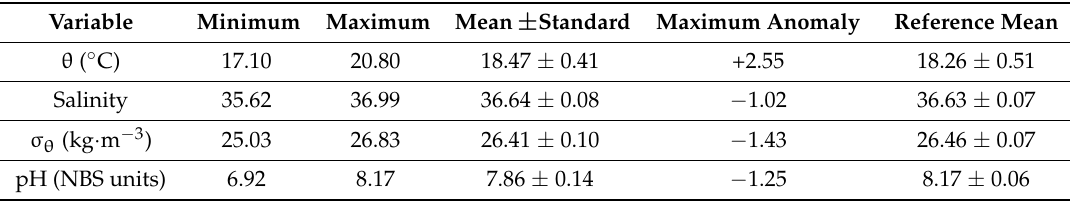
Figure 3. Vertical profile of ( a ) potential temperature, ( b ) salinity, ( c ) potential density, and ( d ) pH, with their standard deviation at the reference stations not affected by the emissions of the submarine volcano. Time series of the same parameters, but recorded by the mooring at the interior of the main crater at a 127 m depth are shown in red. Table 1. Potential temperature, salinity, potential density, and pH statistics. Minimum, maximum, and mean values with their standard deviation, maximum anomalies found in the area, and ref. mean values of non-affected water at the depth of the main crater (127